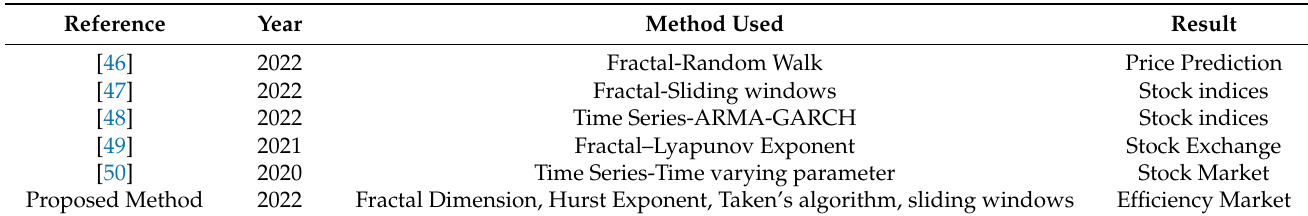
Table 2. Comparative